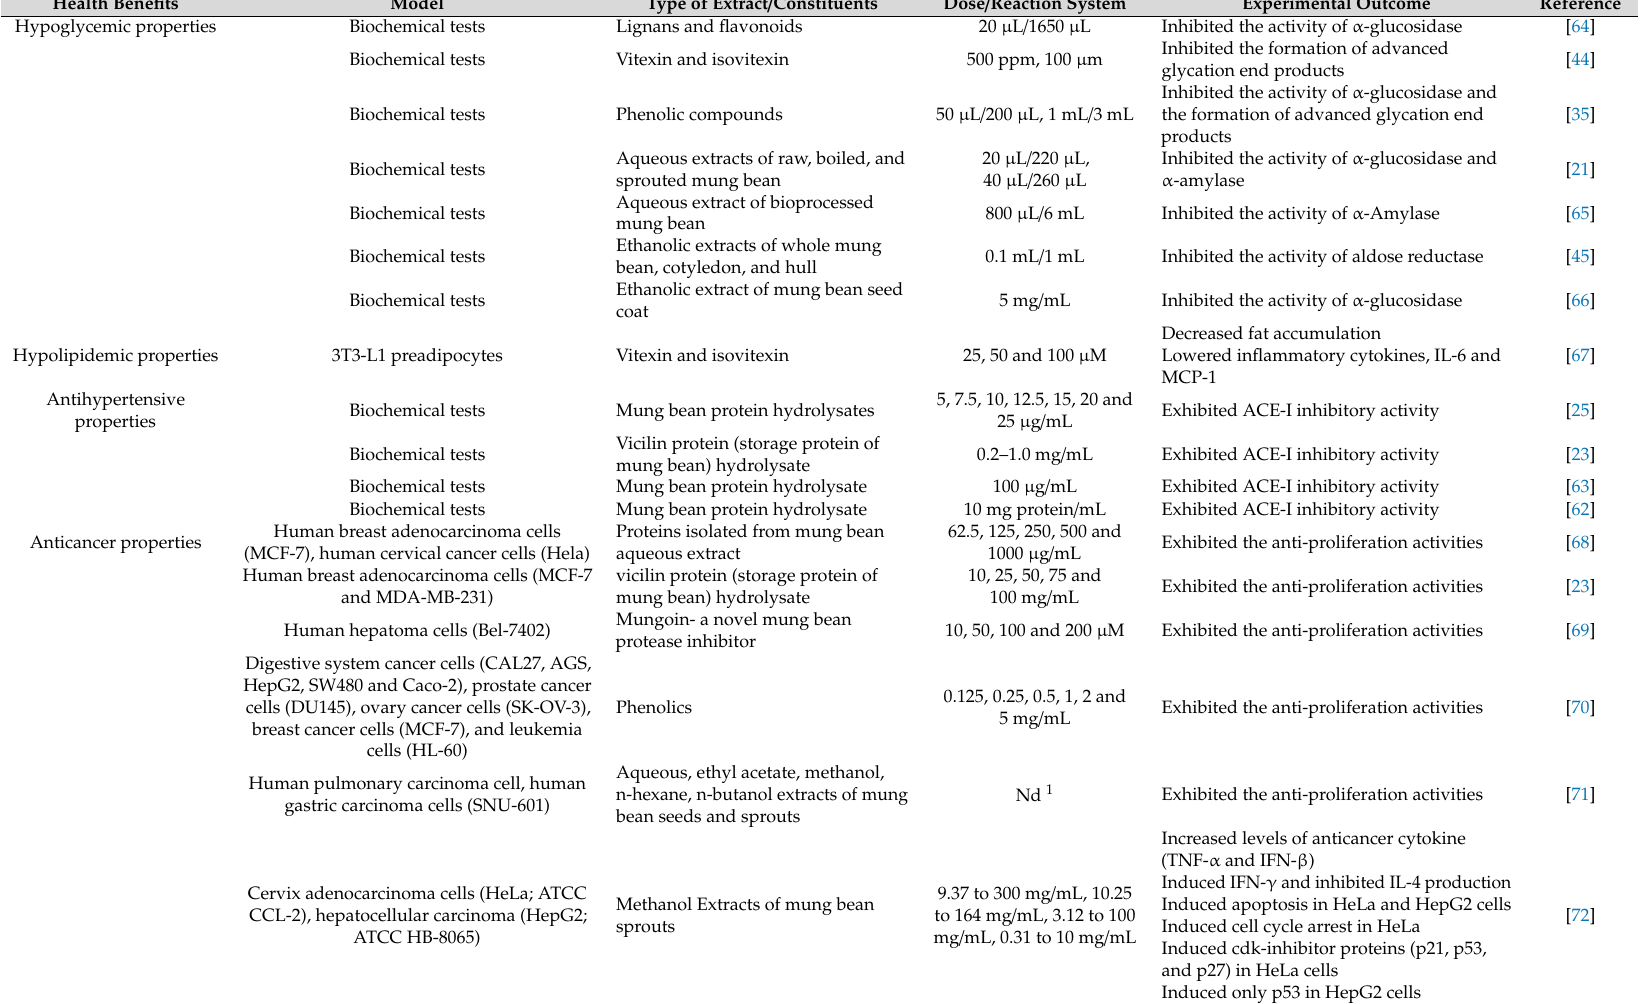
Table 3. In vitro studies of the mung bean and its active compounds in health